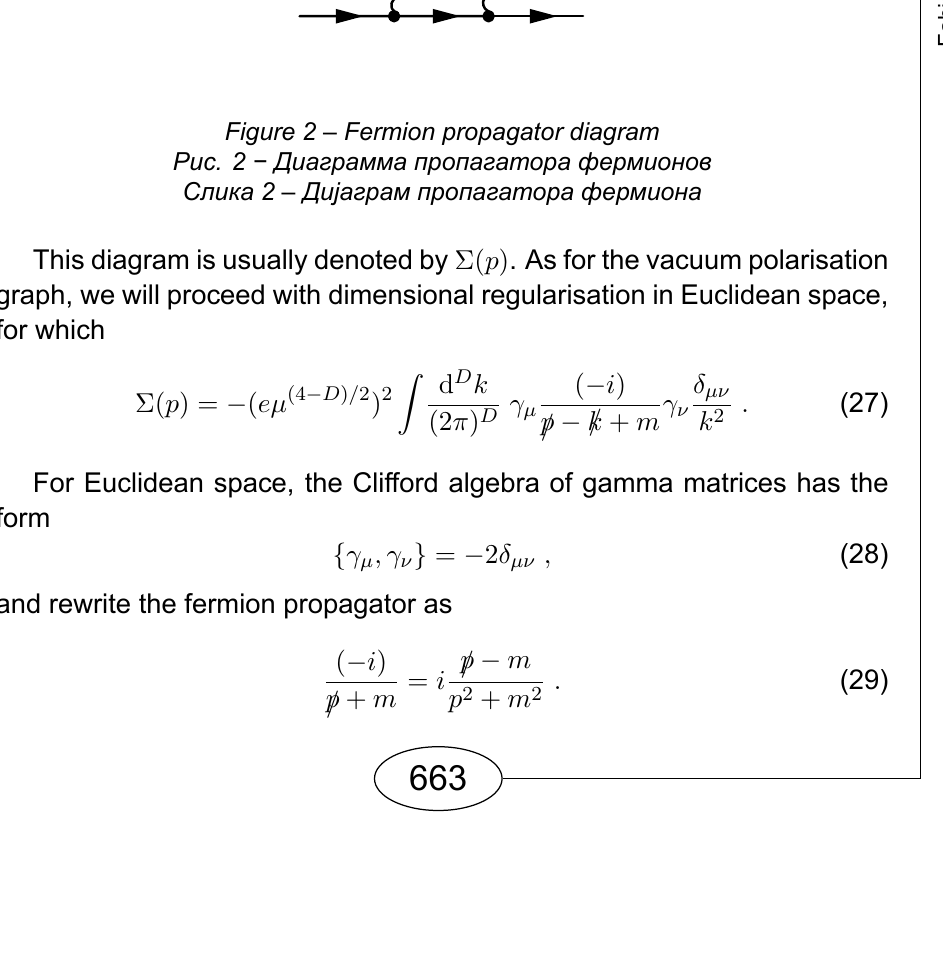
Figure 2 – Fermion propagator